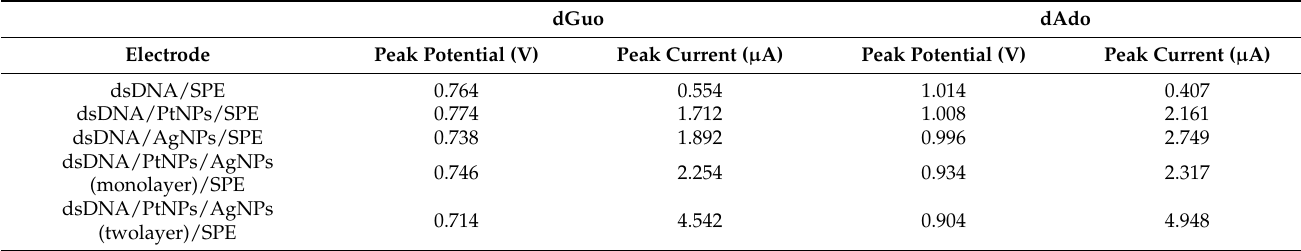
Figure 1. Scanning transmission electron microscopy (STEM) images of platinum nanoparticles/screen-printed electrodes (PtNPs/SPE) ( A ), silver nanoparticles (AgNPs)/SPE ( B ), PtNPs/AgNPs/SPE ( C ) with magnitude of 500.00 KX, energy dispersive X-ray analysis (EDX) analyses of PtNPs/SPE ( D ), AgNPs/SPE ( E ), PtNPs/AgNPs/SPE ( F ). Table 1. The comparison of deoxyguanosine (dGuo) and deoxyadenosine (dAdo) signals in pH 4.70 acetate buffer (AB) by differential pulse voltammetry (DPV) at various modified